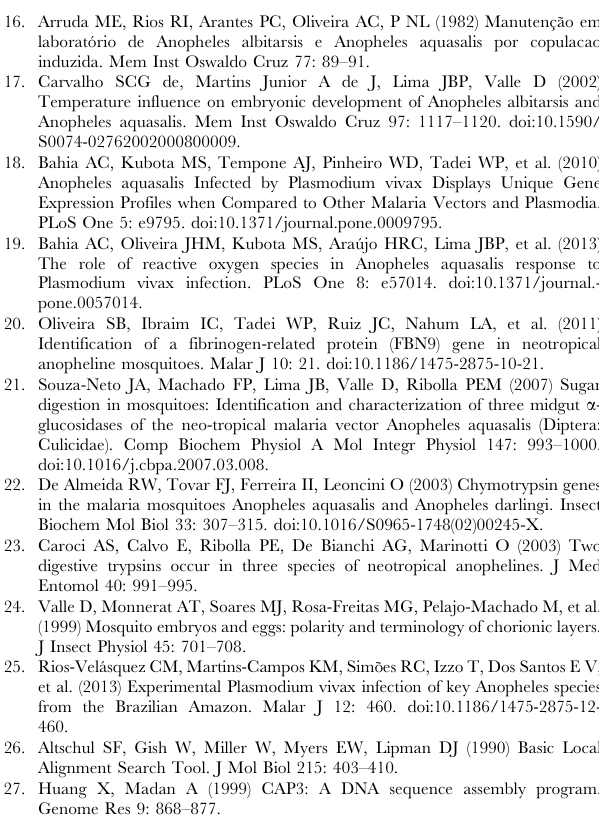
Table S2 Most up or down-regulated transcripts during An.aquasalis development and following a blood meal. Table S3 Primer pairs used for qRT-PCR validation and PCR efficiency of the targets Table S4 Validation of Rp49 as housekeeping gene to normalize expression values of selected